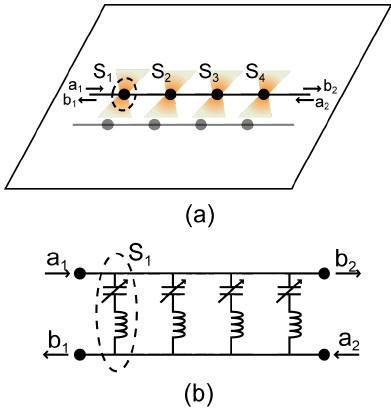
Figure 1. ( a ) An illustration of a capacitive sensor array integrated with a band-stop filter; ( b ) A simplified circuit model for the sensor array. The proximity of the object is detected by the change at the corresponding resonance due to the change in